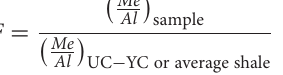
V – 145 ppm] at D03 sampling site ( Supplementary Table